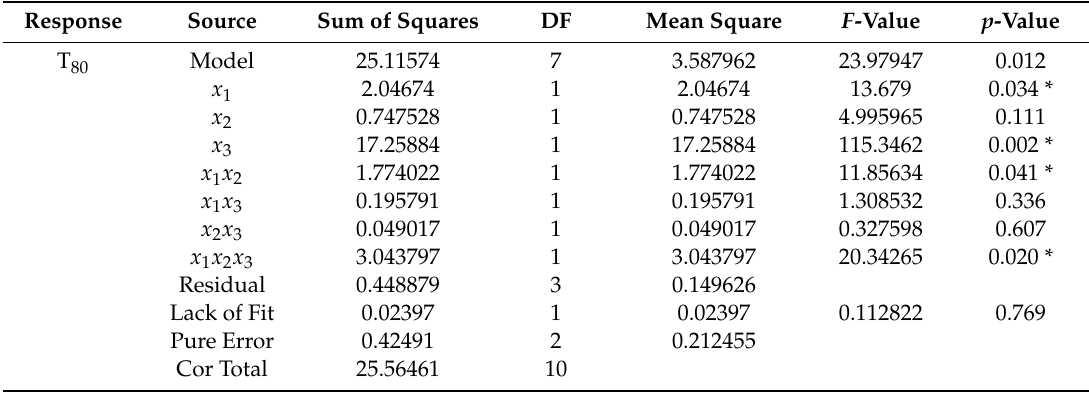
Table 2. Summary of the results of ANOVA for the observed response (T 80 ).